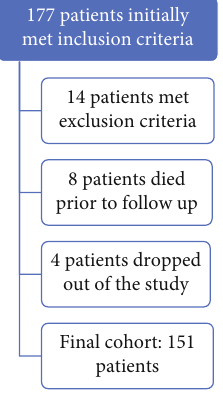
Figure 1: Study fl